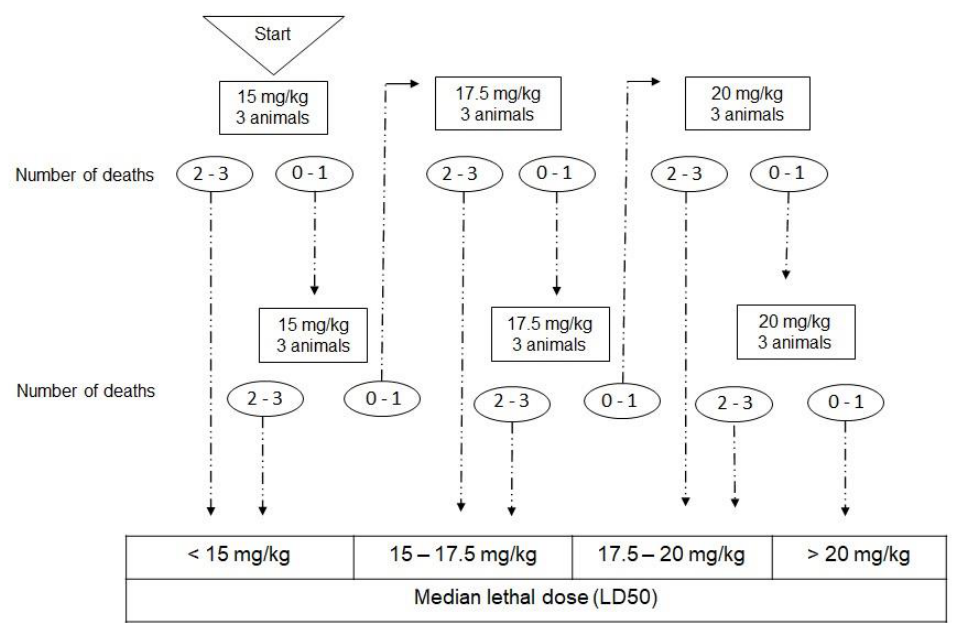
Figure A2. Treatment scheme used to assess the median lethal dose (LD50) after treatment with SpHL-DOX or ExoSpHL-DOX.